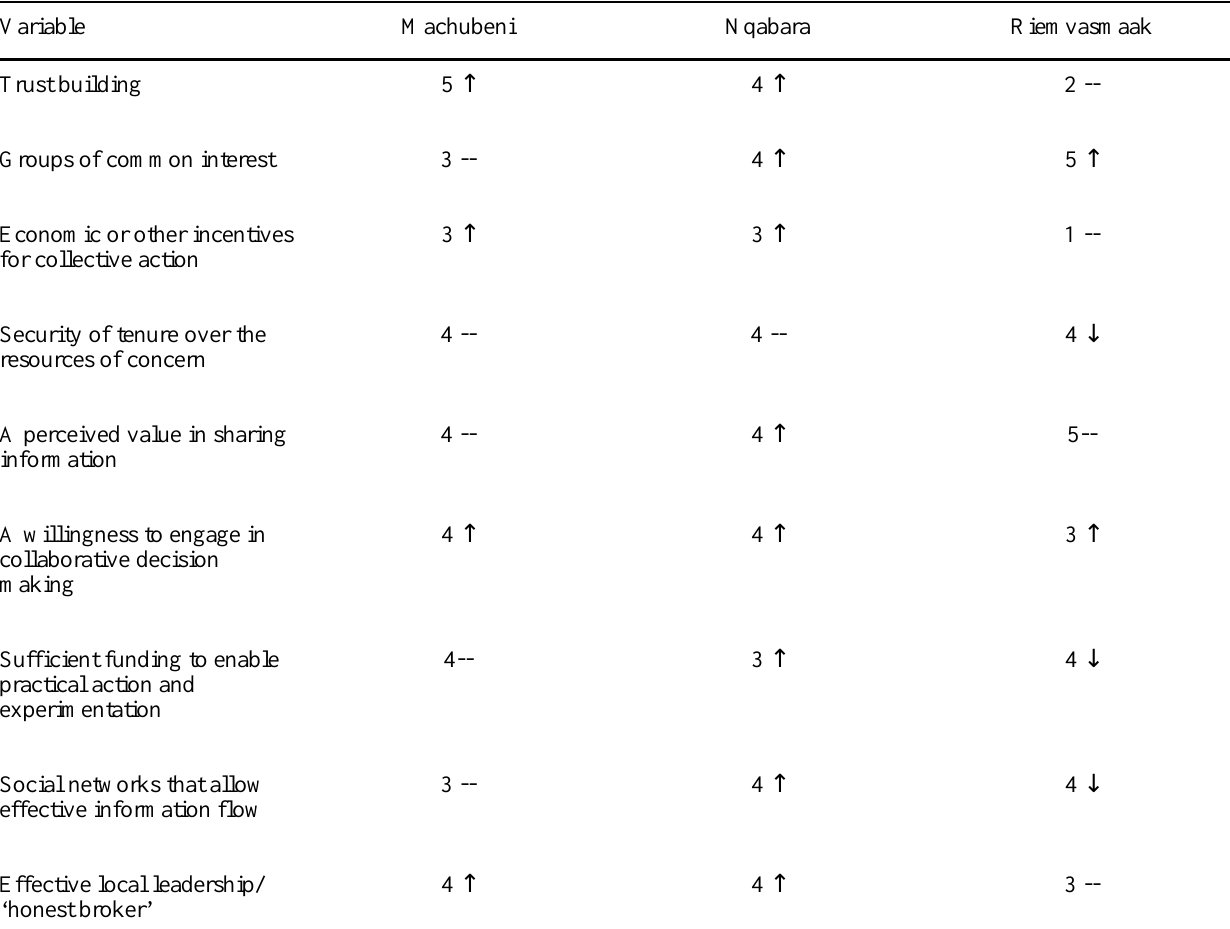
Table 4 . Average ratings and trends in key variables that influence collaboration and social learning.